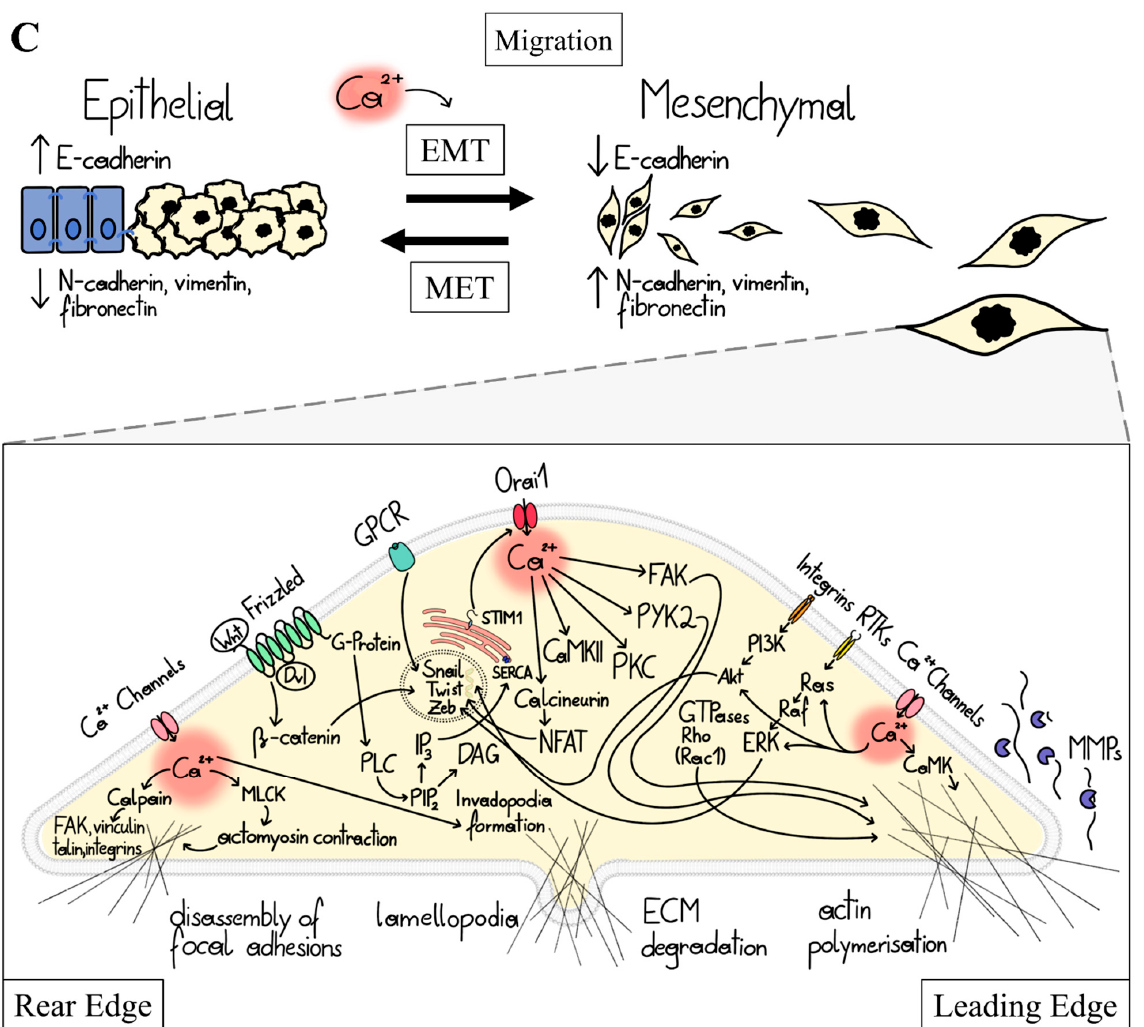
Figure 1. Ca 2+ -dependent cancer signaling pathways controlling proliferation, cell survival, and death and migration. ( A ) The scheme depicts critical pathways for elevation of cytosolic Ca 2+ levels (via PM ion channels (here, the focus is on the store-operated Ca 2+ ion channel named the CRAC channel, i.e., thepore-forming component Orai1) or upon ER-Ca 2+ depletion) that control proliferation at the level of the cell cycle machinery (cyclins, CDKs, CDK inhibitors, centrosome cycle) in a Ca 2+ -dependent manner, either directly via Ca 2+ -binding proteins (CaM, CaMK, CN), or indirectly via transcription factors (NFAT, or immediate early gene (JUN, Myc, and FOS)) and the oncogenic pathways, Ras/ERK and PI3K/Akt. ( B ) Scheme highlights pathways that control cell survival and death factors (e.g., BCL family proteins such as BCL2) in a Ca 2+ -dependent manner. These include factors modulating ER Ca 2+ uptake and Ca 2+ crosstalk between ER and mitochondria (SERCA, p53, Akt, IP 3 R, calpains, caspases). Moreover, the Ca 2+ -dependent modulation of cell fate via oncogenic pathways is shown. ( C ) Top: Schematic representation of the transitions between epithelial and mesenchymal states (MET-EMT (mesenchymal-epithelial transition <-> epithelial-mesenchymal transition)) and the characteristic up- and down-regulations of specific gene expression markers (E-/N-cadherin, vimentin, fibronectin), which are controlled by Ca 2+ . Bottom: Ca 2+ -dependent pathways controlling highly coordinated migration together with contacts to the extracellular matrix at the rear and the leading edge of the cell. At the leading edge, Ca 2+ triggers lamellipodia formation by actin polymerization, the assembly of focal adhesions, the formation of contact with the bottom, and matrix metalloproteinases (involving small GTPase, such as Ras and Rac1, Ca 2+